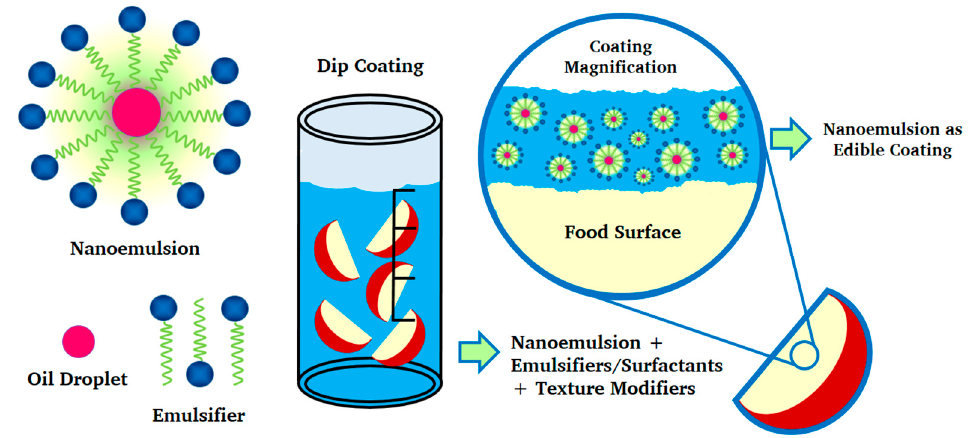
Figure 1. Nanoemulsion in edible coatings, food interaction. Table 1. Studies of the impact of nanoemulsions as edible coatings in different foods on shelf life, antioxidant capacity and antimicrobial and enzymatic inhibition.